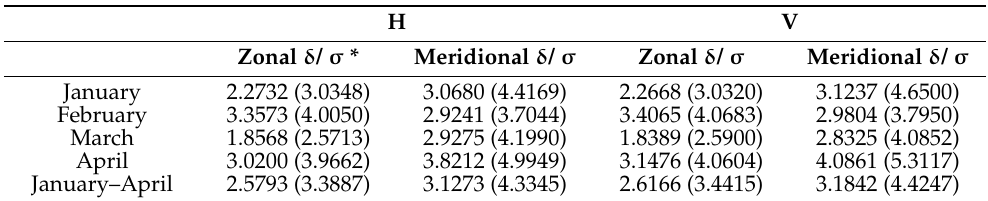
Table 4. Error ‐ related statistics of the retrieved sea ice motion from FY ‐ 3D/MWRI T b data at 36.5 GHz in the Beaufort Sea.